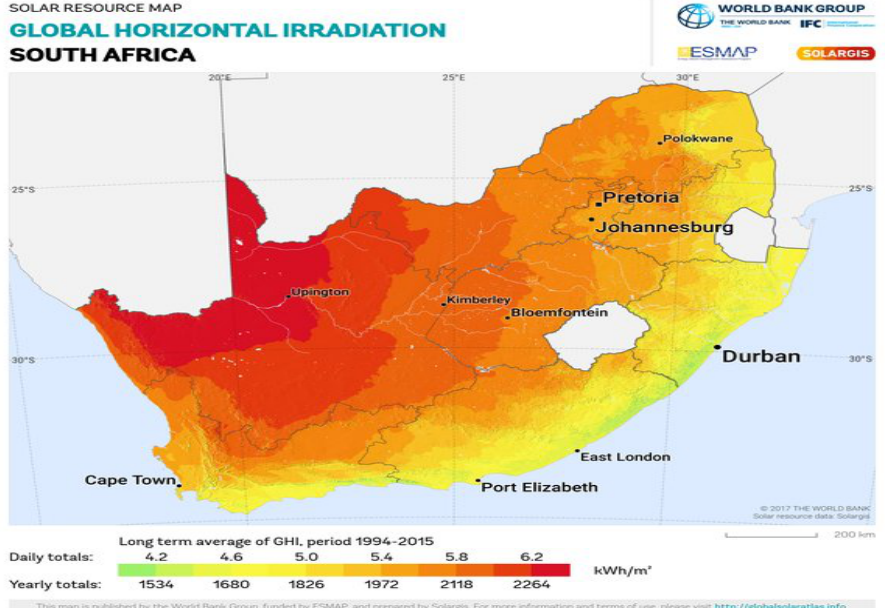
Figure A1. Solar heat map. Source: https://solargis.com/maps-and-gis-data/download/south- africa, accessed on 8 July